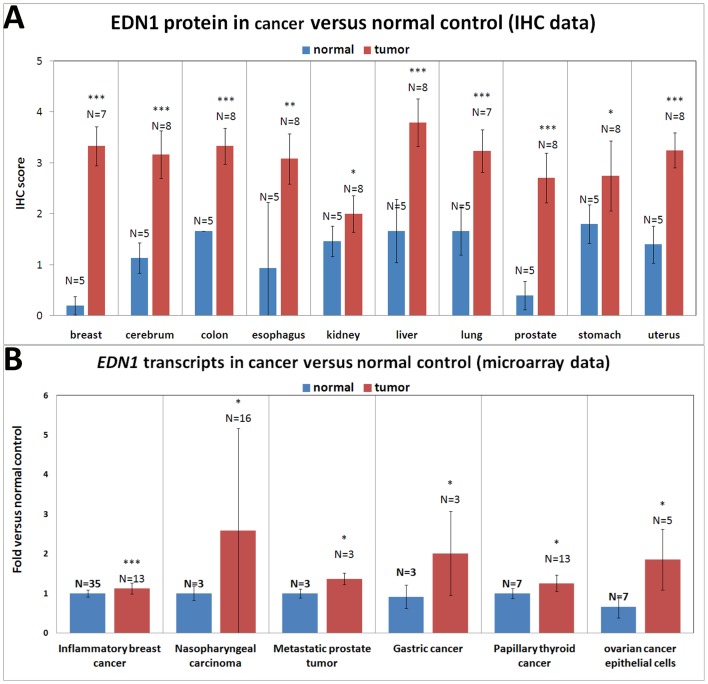
EDN1 protein and mRNA expression in various human tumor and normal tissue samples.(A) To assess EDN1 protein expression in human normal and tumor tissues, the IHC staining of the indicated tissues was performed and the staining intensity was evaluated. A score from 0 to 4 was allocated to each sample and the scores from the same tumor types were averaged. The numbers of samples for each tumor/normal type are indicated. EDN1 expression was enhanced in all tumor types examined. The differences among the variables were assessed using a two-tailed Student's t-test. Significant differences between the normal and tumor tissues are indicated (*, P<0.05; **, P<0.01; and ***, P<0.001). (B) EDN1 mRNA expression from the GSE data set. The data of inflammatory breast cancer, nasopharyngeal carcinoma, metastatic prostate tumor, gastric cancer, papillary thyroid cancer, and ovarian cancer were obtained from the GDS3097, GDS3610, GDS2865, GDS1210, GDS1732, and GDS3592 data set, respectively. The numbers of samples for each tumor/normal type are indicated. Over-expression of EDN1 transcripts was observed in all tumor types examined. The differences among the variables were assessed using a two-tailed Student's t-test. Significant differences between the normal and tumor tissues are indicated (*, P<0.05; **, P<0.01; and ***, P<0.001).